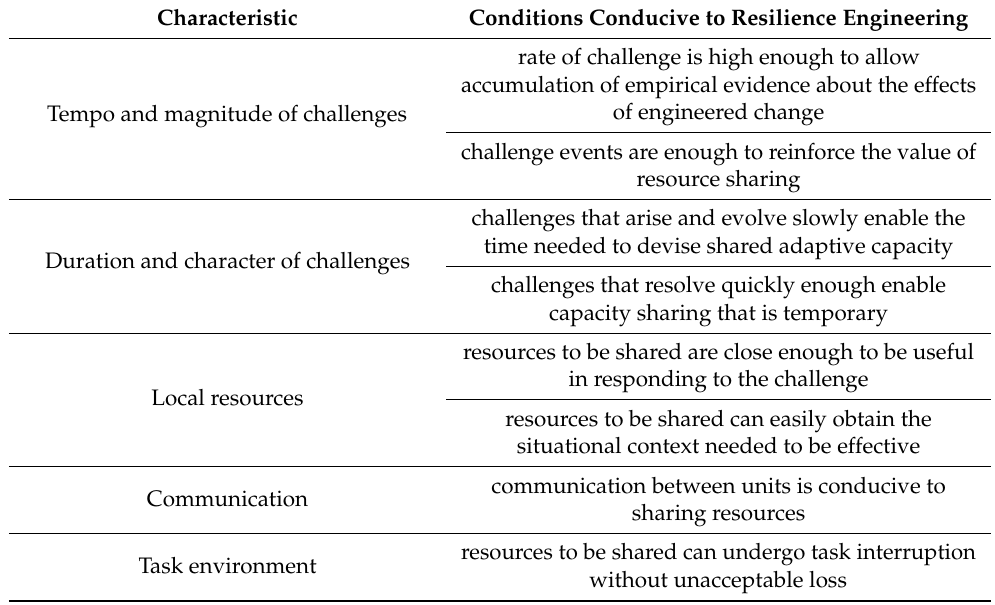
Table 2. Conditions likely to foster resilience actions and abilities, based on empirical studies (adapted from Cook & Long